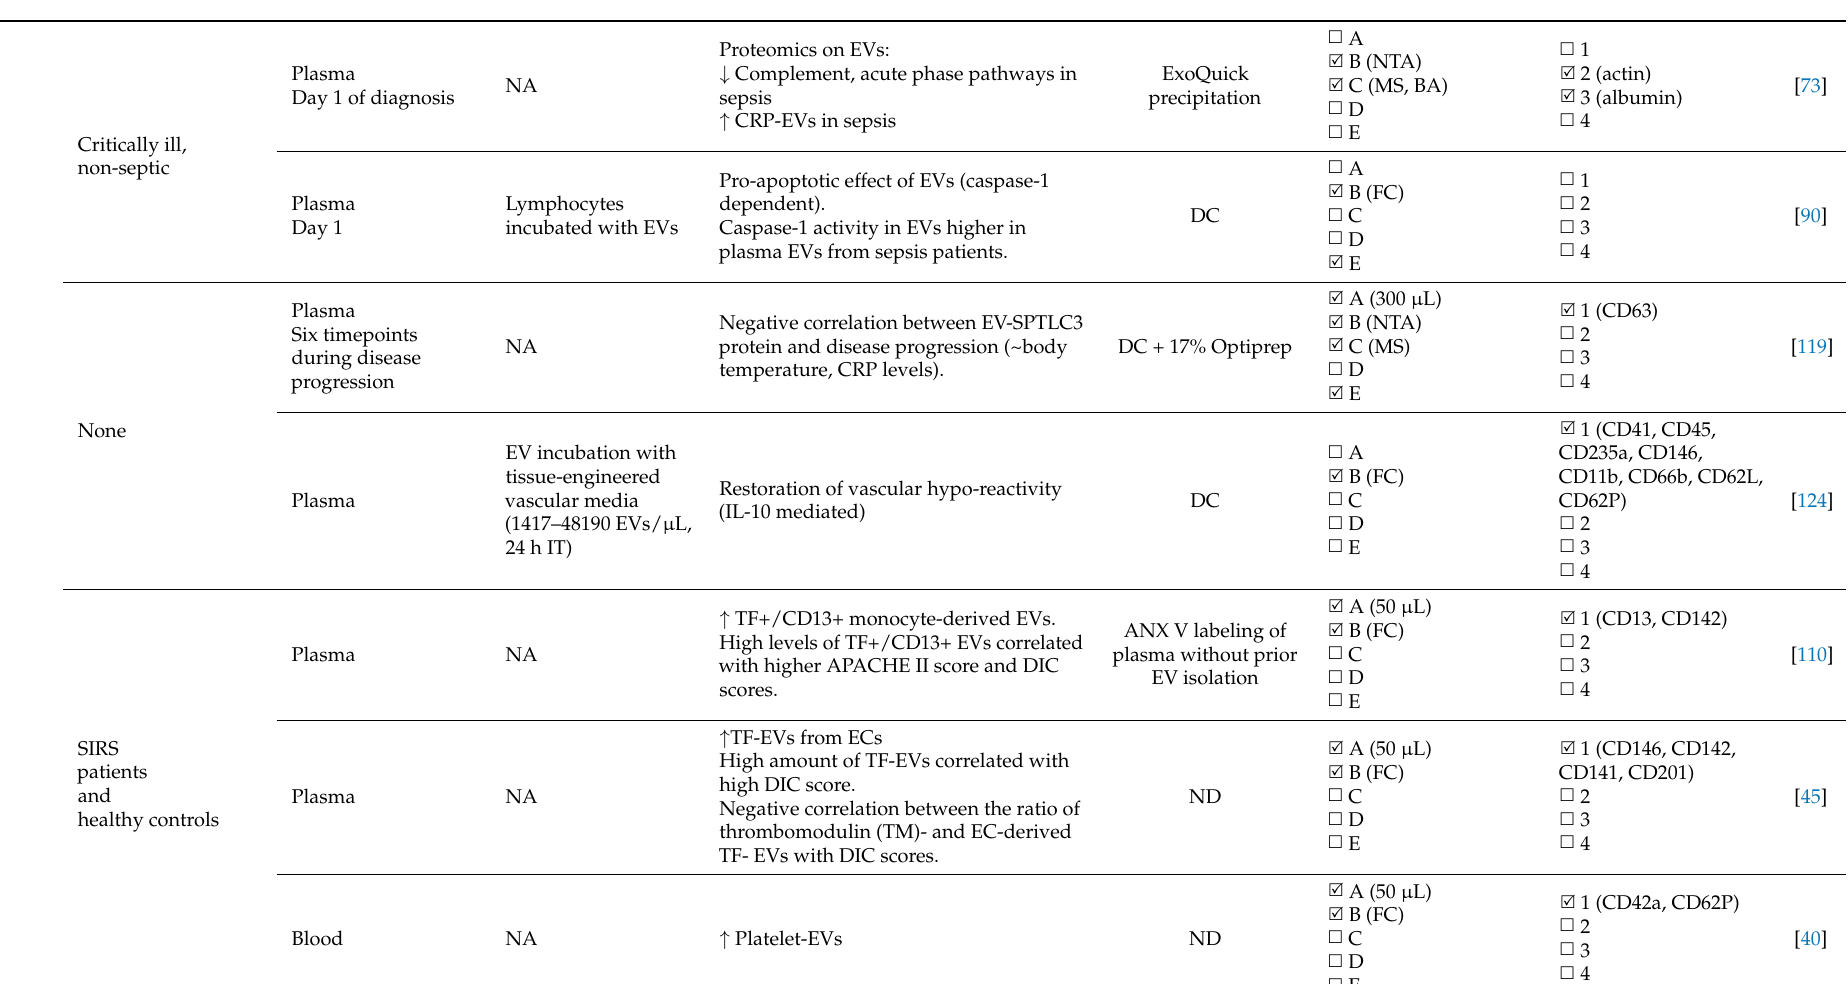
↑ PS-EVs Combination of prothrombin time, EC-derived CD105+ EVs and platelet count at D1 could predict DIC ab- sence. Total EV amount in same range for DIC and non-DIC patients. Specific EV source pattern in DIC patients. ↓ Platelet-derived EVs in DIC patients compared to non-DIC patients vors. ↑ EC-EVs and leukocyte EVs in DIC (D1)